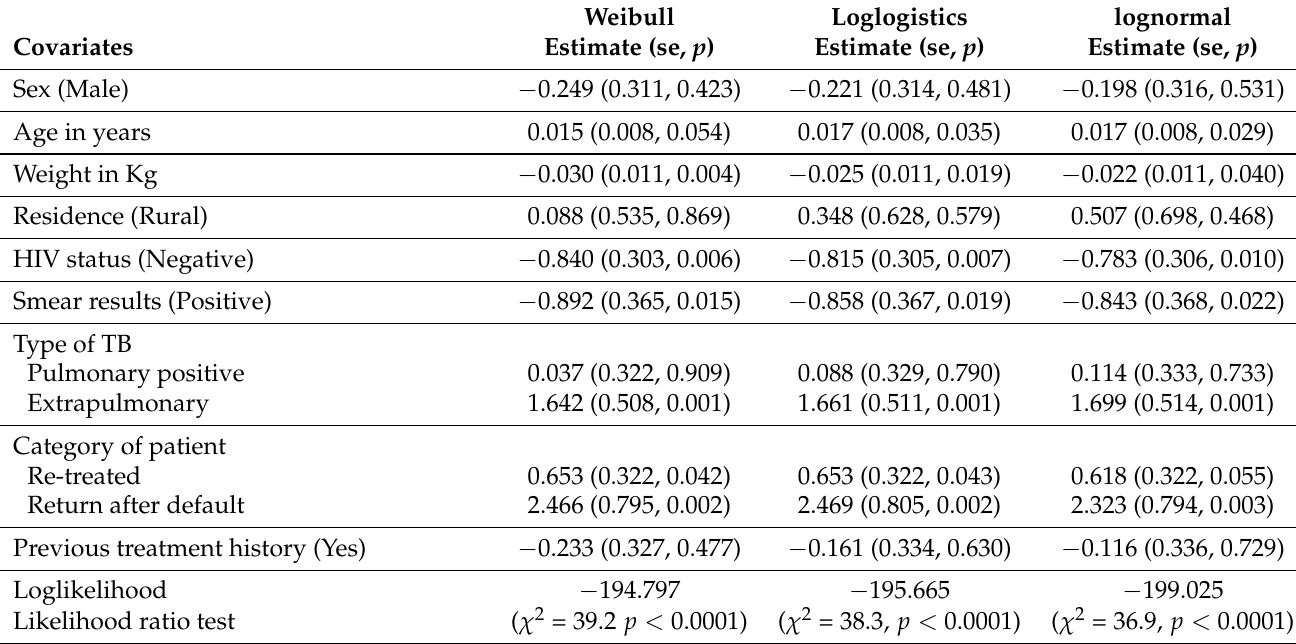
Table 4. Parameter estimates, standard error (se) and p -value ( p ) of survival models with parametric baseline hazard distribution for time to death of TB